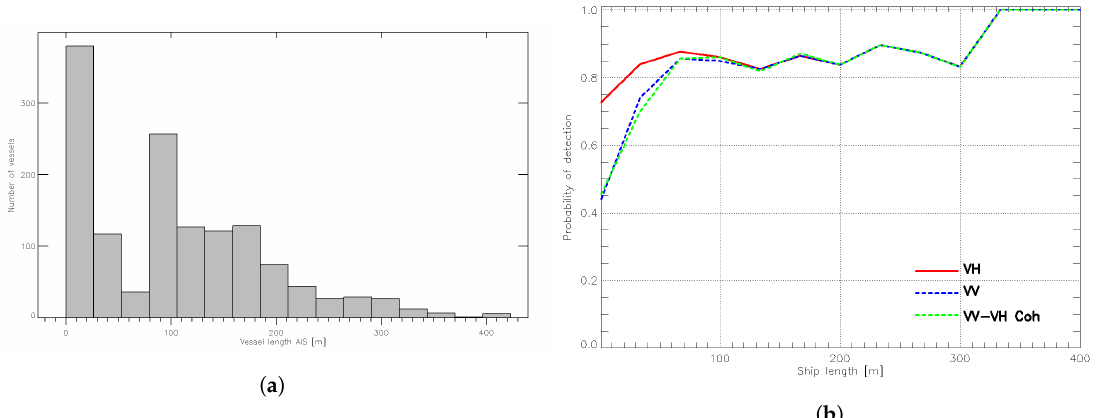
Figure 6. Statistical analysis of the detection performances derived for 1400 vessels extracted from 10 SAR images and the corresponding AIS data flow: ( a ) AIS vessel length distribution; ( b ) probability of detection as a function of polarization and vessel